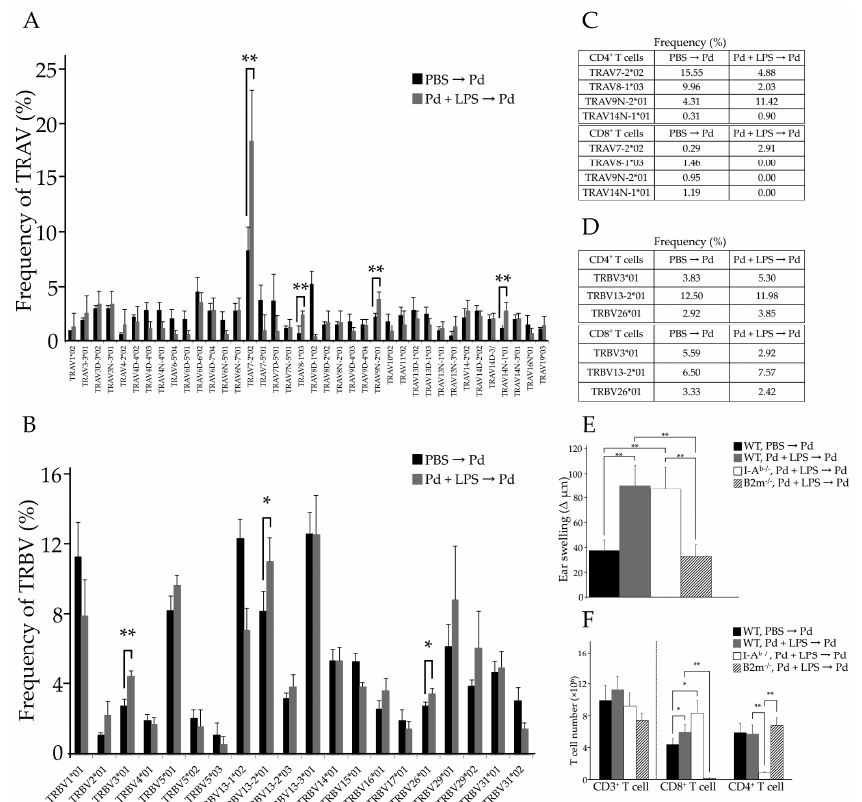
Figure 2. The frequency of TRAV ( A ) and TRBV ( B ) repertoires were compared between unsensitized-WT mice and sensitized-WT mice ( n = 4); ( C , D ) The skewing of TCR repertoires in CD8 + and CD4 + T cells was analyzed. Ear swelling ( E ) and the number of T cells in each subset ( F ) were compared among unsensitized- WT mice, sensitized-WT mice, sensitized-I-A b − / − mice, and sensitized-B2m − / − mice ( n = 4–5). Values are means ± SD. * p < 0.05 and ** p < 0.01. Similar results of ear swelling ( E ) and T cell numbers ( F ) were